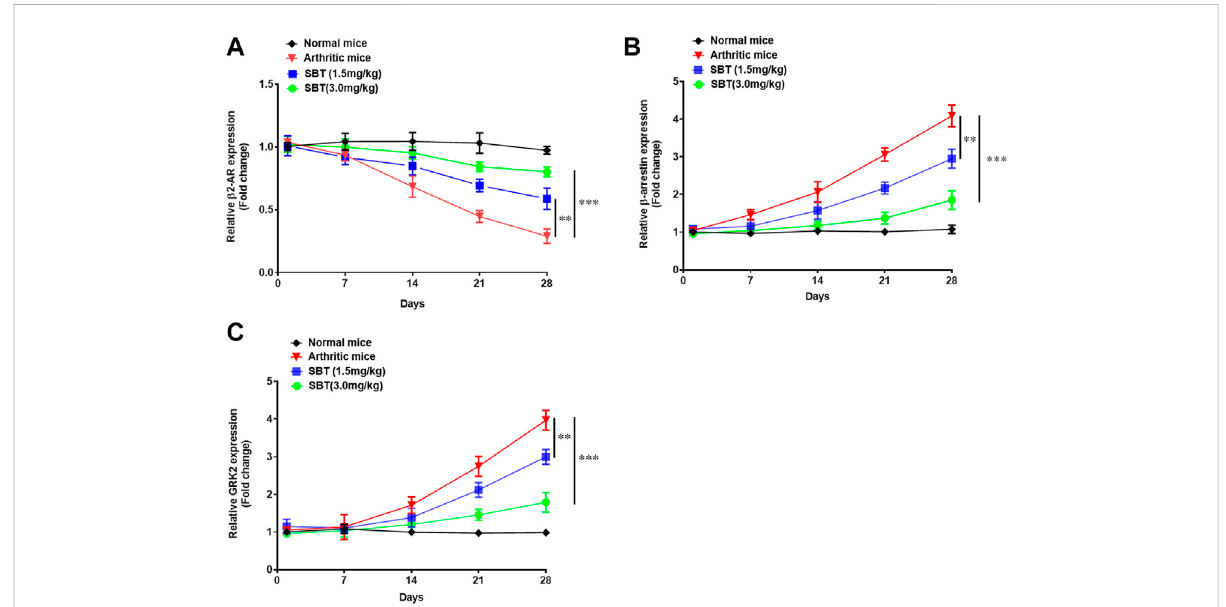
FIGURE 10 Mice wereeuthanizedon weeklybasis under4%chloralhydrate generalanesthesia,andchondrocyteswereisolated frommice cartilage under sterileconditions.RNAswereisolatedbyTrizolreagent,convertedtocDNAandqPCRwasperformedtoanalyzetherelativeexpressionof β 2-AR (A) , β -arrestin (B) and GRK2 (C) . Data were analyzed by GraphPad prism version 7.0. Signi fi cance of data was measured by using Two Way ANOVA